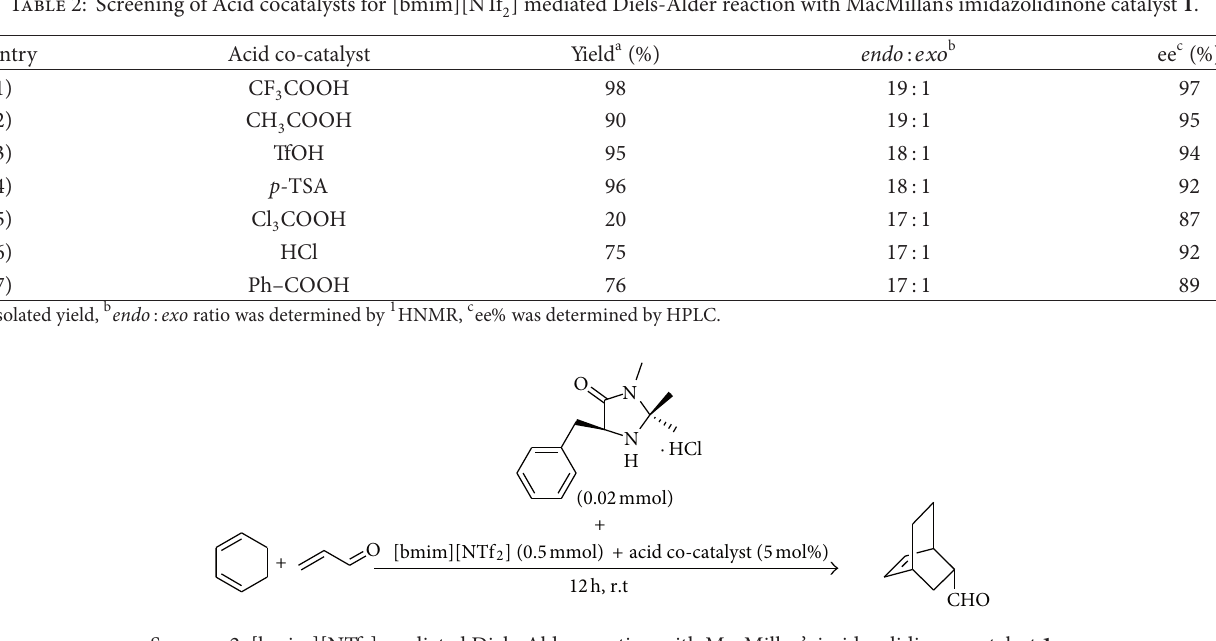
T 2: Screening of Acid cocatalysts for [bmim][NTf